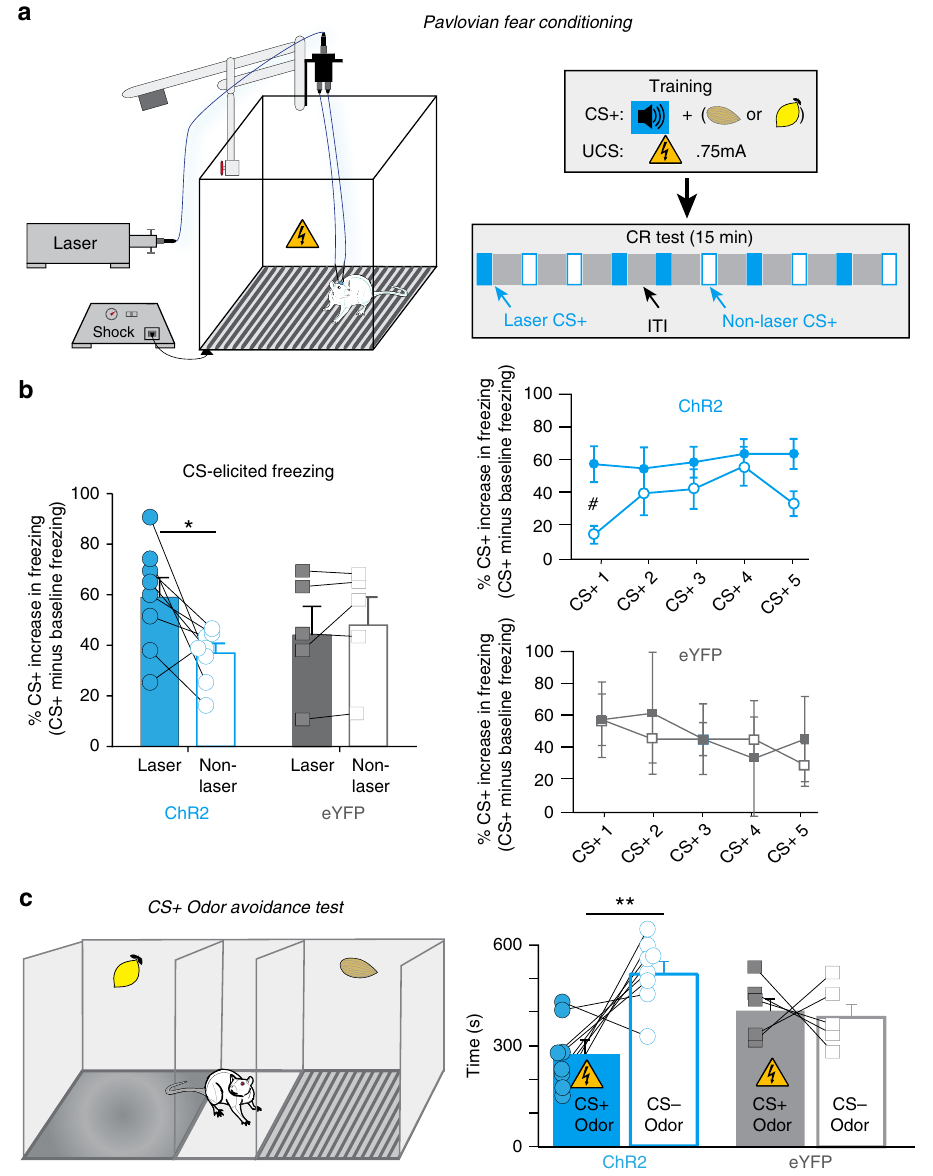
Fig. 6 CeA stimulation during Pavlovian fear conditioning. a Traditional Pavlovian fear conditioning paradigm: defensive freezing CR elicited by a CS + tone that predicts unavoidable footshock UCS in Pavlovian chamber. Contextual odor CS + (almond or lemon scent) was also paired with UCS shock chamber. Right shows training stimuli and session timeline. b Freezing conditioned response (CR) during subsequent test session without UCS (% CS- elicited freezing minus % baseline freezing; ChR2 rats, N = 8, eYFP rats, N = 5, two-way ANOVA, trial type × virus interaction: F 1,11 = 5.07, p = 0.036; Bonferroni-corrected pairwise ChR2 laser vs. nonlaser trials t -test: p = 0.035). Right graphs show individual freezing CRs elicited by CS + presentation over pre-CS + baseline (ChR2: two-way repeated measures ANOVA, effect of laser: F 1,7 = 7.36, p = 0.03, 1st trial laser vs. nonlaser freezing: